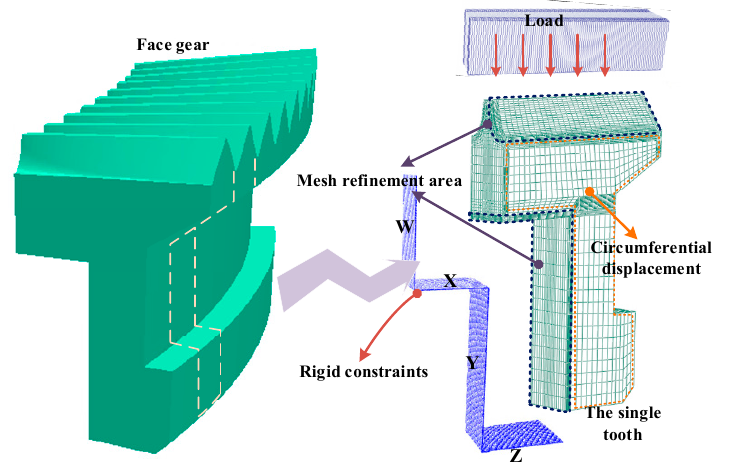
Figure 6. Geometry and mesh of the face gear model; boundary constraints for die quenching.